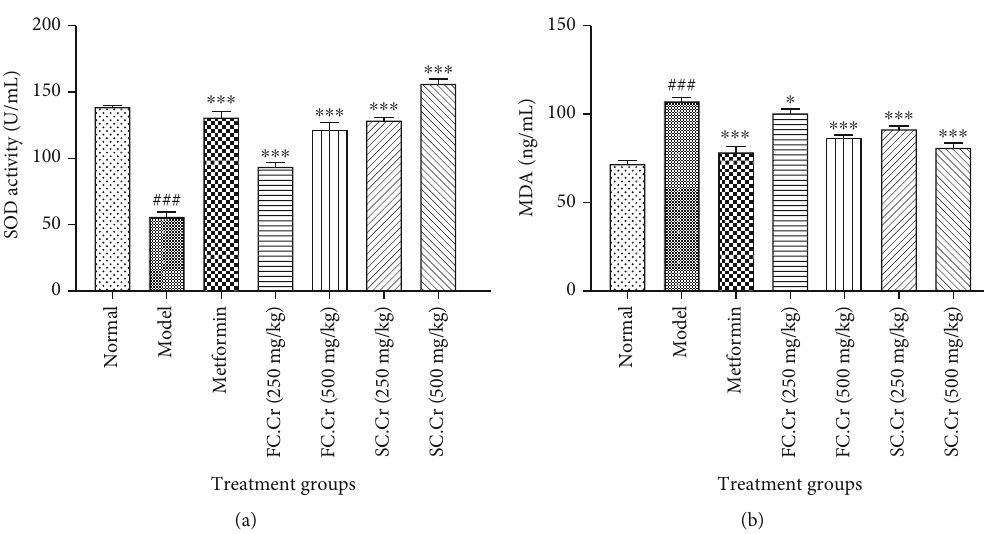
Figure 5: E ff ects of FC.Cr. and SC.Cr. on plasma levels of SOD (U/mL) and MDA (ng/mL) in HFD-STZ-induced rats. FC.Cr. and SC.Cr. were administered at 250 mg/kg and 500mg/kg after three weeks till the end of study duration. SOD (a) and MDA (b) were measured after drawing plasma from the treated and normal group of rats. The values are expressed as the mean of six animals in a group. Statistical analysis is performed with one-way ANOVA followed by Tukey ’ s test. All the groups are compared with the HFD-STZ group, while the HFD-STZ group is compared with the normal group. Results are considered signi fi cant ( ∗ ) if P < 0 : 05 , ( ∗∗ ) and if P < 0 : 01 and highly signi fi cant ( ∗∗∗ ) if P < 0 : 001